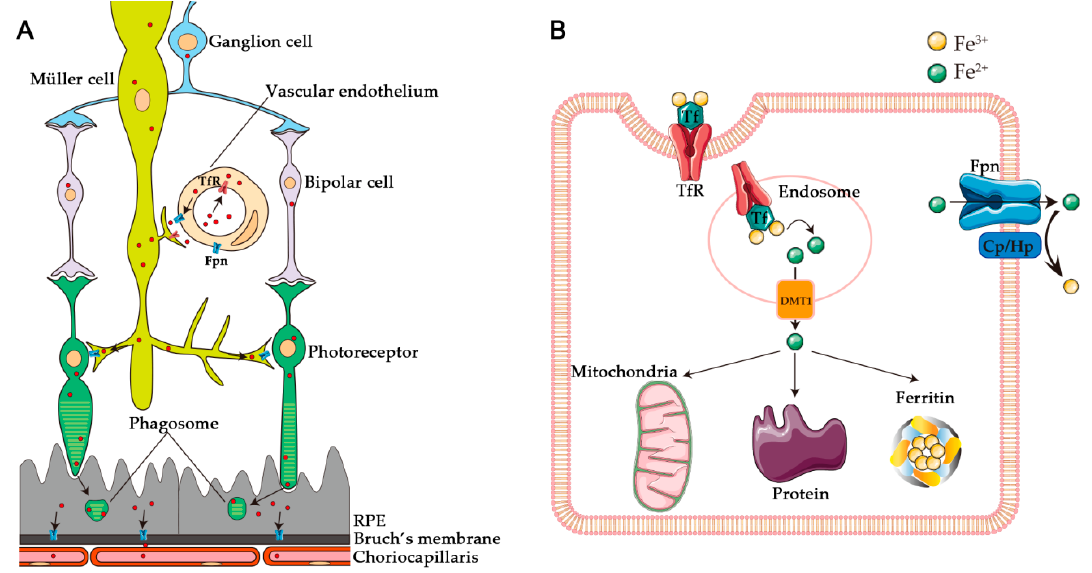
Figure 1. Schematic illustration of retinal iron transport. ( A ) Iron (red dots) moves through the retina as shown by arrows. Based on immunolocalization of TfR and Fpn, iron can enter retinal vascular endothelial cells by TfR-mediated endocytosis. It exits the vascular endothelial cells through Fpn (transmembrane protein indicated in blue). It is distributed through the neural retina by Müller glial cells. Iron is transferred from photoreceptors to the RPE through daily phagocytosis of the photoreceptor outer segments by the RPE. It is then exported by Fpn on the basolateral RPE into the choriocapillaris. ( B ) Iron transport at the cellular level. Iron can be taken into the cell by TfR, exported from the endosome by Dmt1, imported into mitochondria, stored in ferritin, or exported from the cell by Fpn in cooperation with ferroxidases Cp or Hp. Cp, ceruloplasmin; Dmt1, divalent metal transporter-1; Fpn, ferroportin; Hp, hephaestin; Tf, transferrin; TfR, transferrin receptor. “Channels”, “Mitochondria” and “Protein” by Servier Medical Art by Servier are licensed under CC BY 3.0.